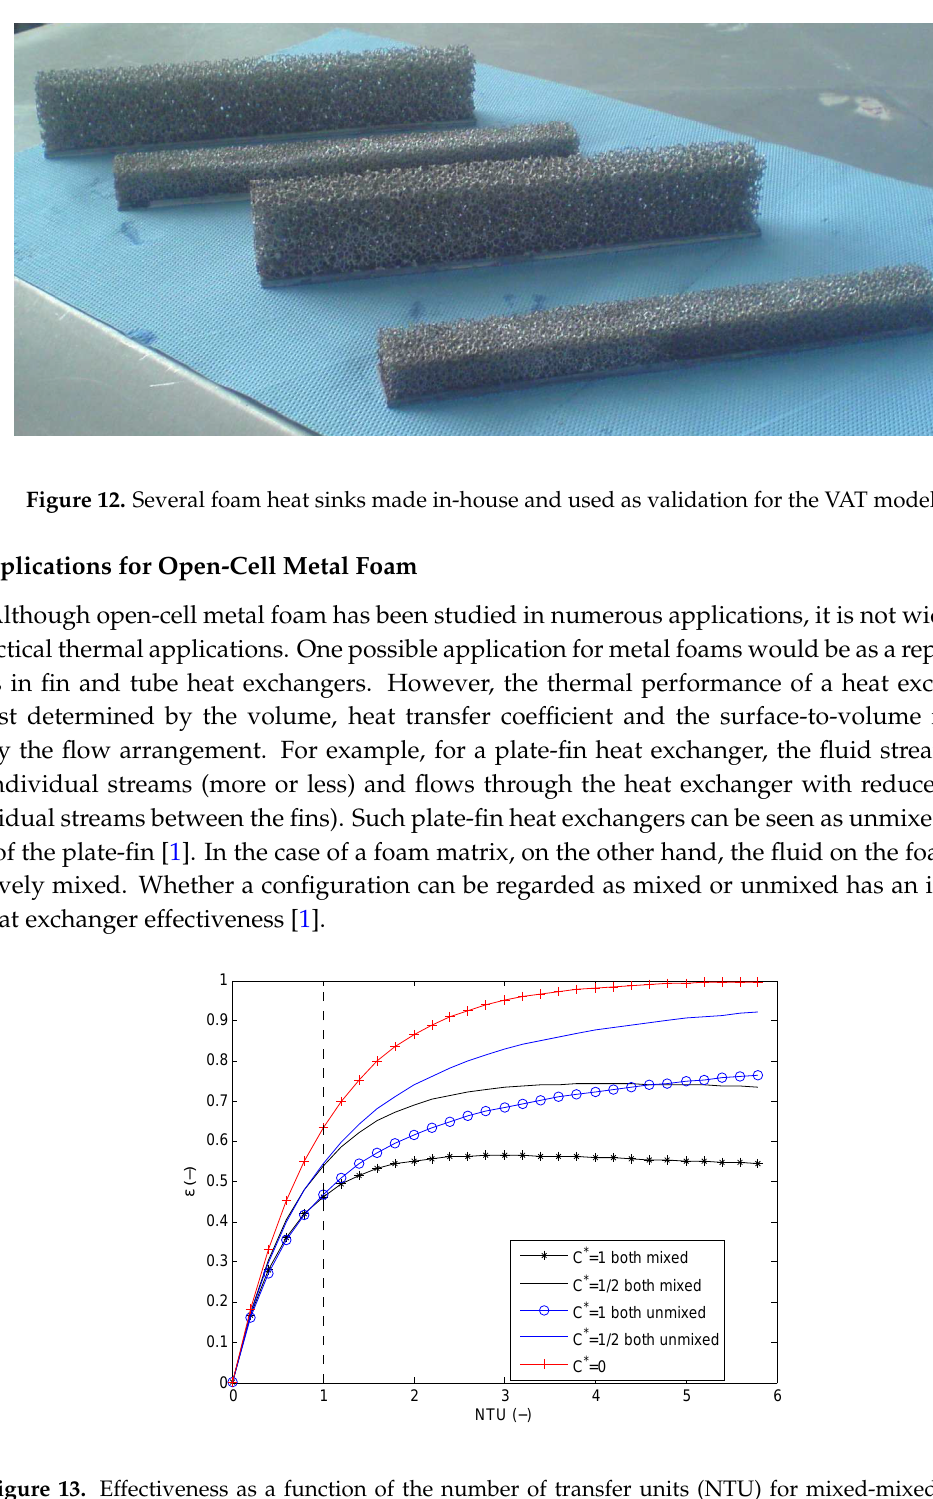
Figure 13. Effectiveness as a function of the number of transfer units (NTU) for mixed-mixed and unmixed-unmixed flow